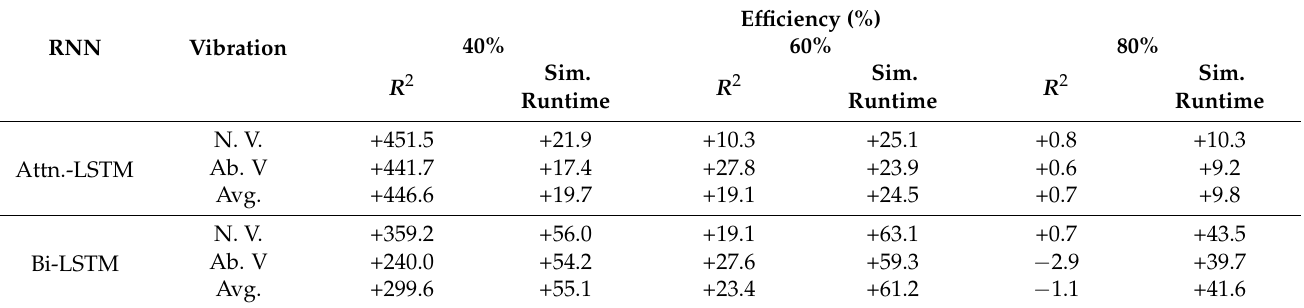
Table 6. Comparison of the rate of change between Attn.-LSTM and